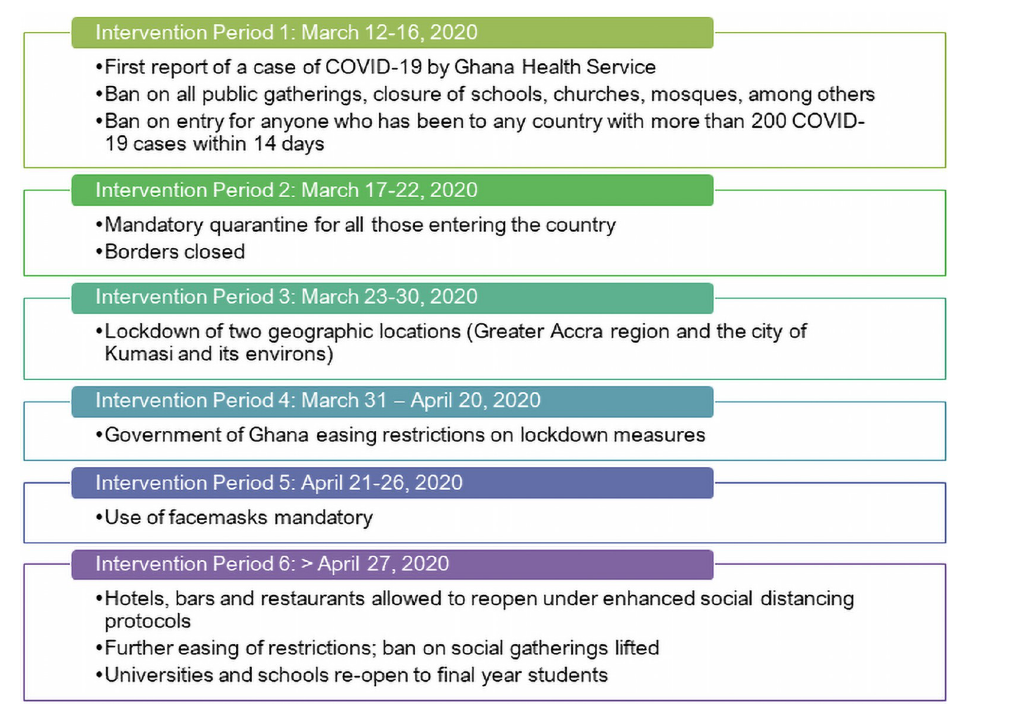
Fig 6. Summary of intervention periods and public health measures